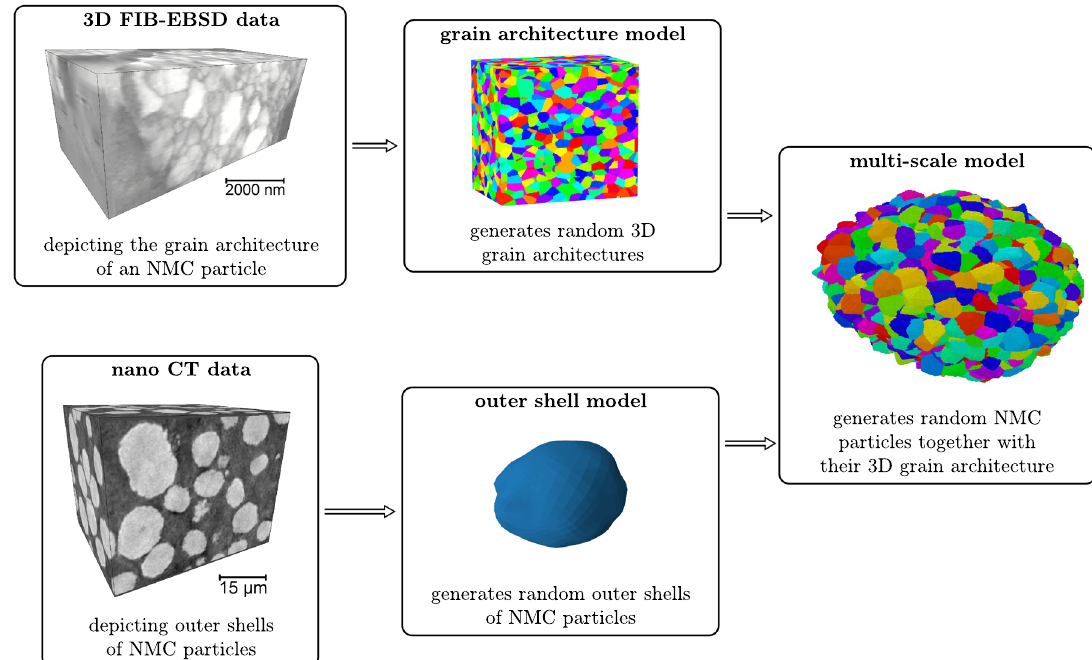
Fig. 1 Scheme for stochastic multi-scale modeling of NMC particles. Using FIB-EBSD data depicting the grain architecture of an NMC particle (top, left), a 3D grain architecture model is developed which generates digital twins of the segmented FIB-EBSD data (top, middle). On the other hand, using nano-CT data depicting a large number of NMC particles (bottom, left), a 3D model for the outer shell of NMC particles is developed which generates random particle shells (bottom, middle). By combining both models, a stochastic multi-scale model is obtained for both the outer shell and the grain architecture of NMC particles